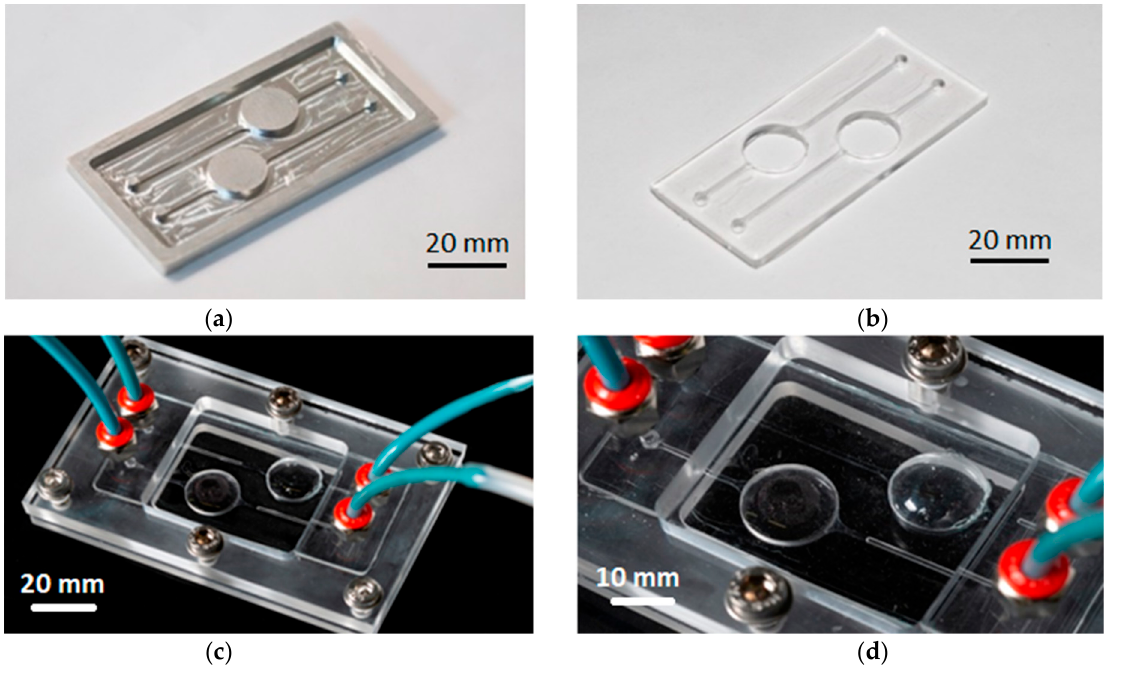
Figure 3. ( a ) Master obtained by micro-milling aluminum components, resembling the final cell culture unit’s microstructures; ( b ) cell culture unit, sealed and bonded to a PDMS membrane (upper part) and to a glass coverslip (bottom part); ( c ) final PDMS cell culture unit sandwiched between PC layers. PC were provided with inlet and outlet ports, positioned to match the ends of the PDMS cell culture unit, machined to accommodate standard fittings for the four ports for flowing fluids through the cell culture unit; ( d ) close-up view of the cell culture chambers, sealed on top with the oxygen-permeable PDMS